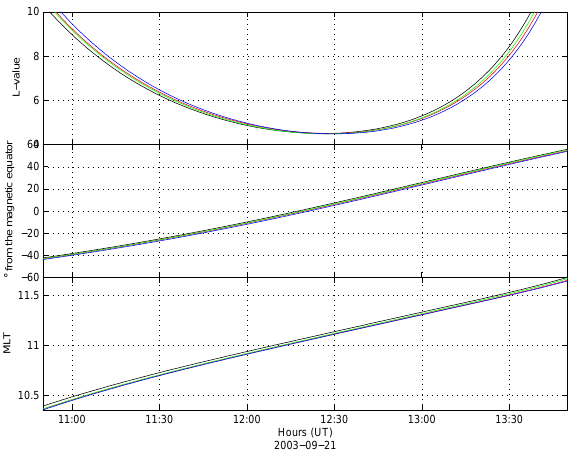
The high values ( ∼ 100) of the azimuthal wave number found in all three events are consistent with the poloidal mode type polarisation of the wave magnetic field. All of the studied events are located within (4 ≤ L ≤ 6). Many authors have stud- ied the eigenfrequencies for geomagnetic ULF pulsations (e.g. Cummings et al., 1969; Schulz, 1996; Takahashi et al., 2004). These studies adopted a power law for the plasma density along a field line: